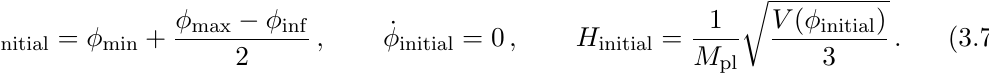
Figure 3 . Instability bands for the KKLT model with a = 2 (cid:25) , A = 10 and W W 0 = 10 (cid:0) 5 (right). The (cid:12)gure shows the real part of the Floquet exponent j< [ (cid:22) k ] j in units of the Hubble parameter H initial as a function of the amplitude of the homogeneous (cid:12)eld (cid:30) initial